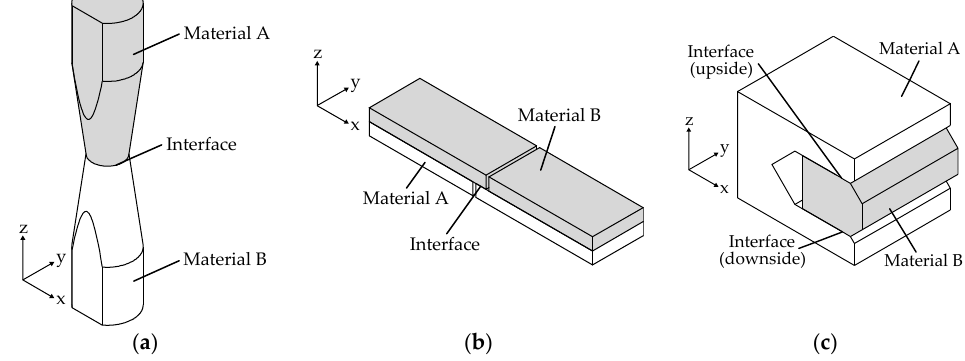
Figure 3. Developed test specimens for the characterization of multi-material ME parts with regard to three exemplarily load types: ( a ) tensile, ( b ) lap-shear, and ( c ) compression-shear (scale-factor: 2); isometric view.